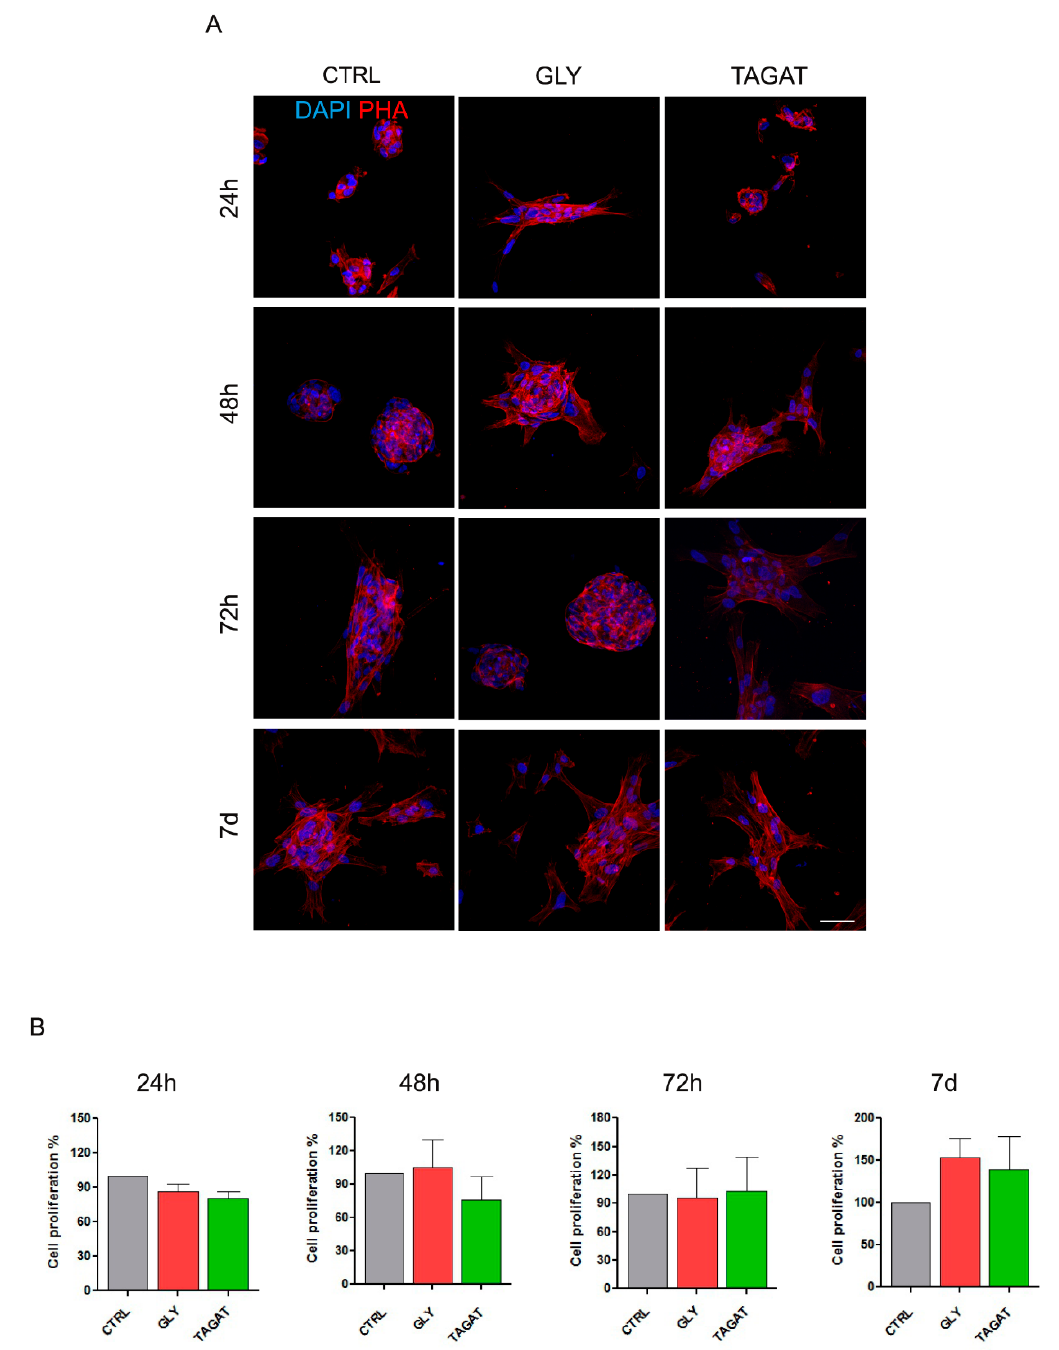
Figure 3. Stem cell morphology, adhesion and proliferation. ( A ) hDPSCs morphology was evaluated by immunofluorescence analysis of phalloidin (PHA)-stained cells at different time points (24 h, 48 h, 72 h, 7 d) on titanium surfaces previously cleansed with GLY and TAGAT. Control group (CTRL) consisting of hDPSCs seeded on untreated titanium surfaces. Nuclei were counterstained with DAPI. Scale bar = 50 µ m. ( B ) Histograms represent cell proliferation (24 h, 48 h, 72 h, 7 d) of hDPSCs seeded on disks from different experimental groups and one-way ANOVA followed by Newman-Keuls post hoc test. Experiments were performed in triplicate.